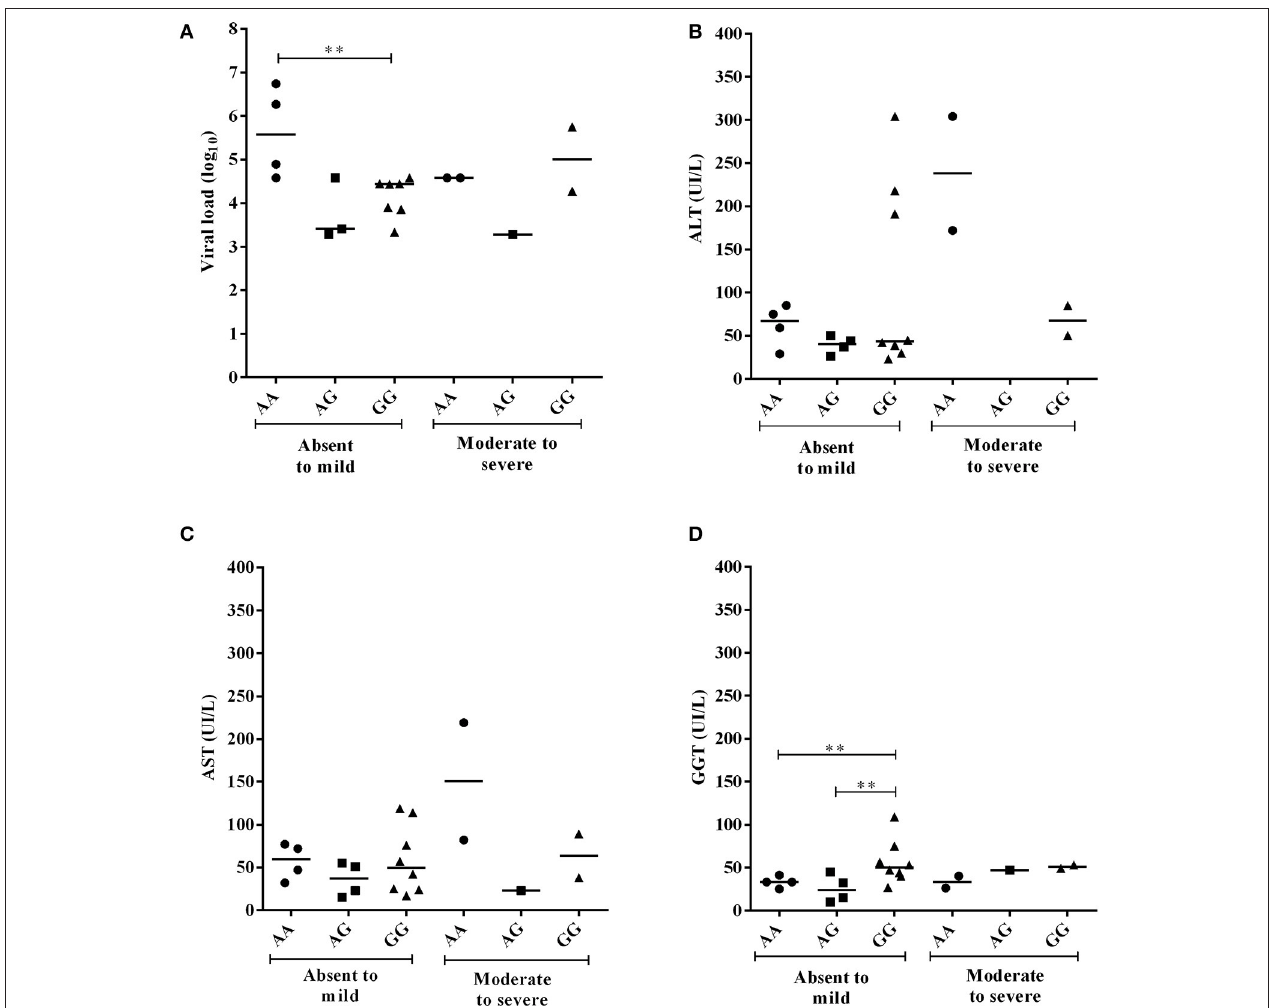
FIGURE 5 | Comparison of plasma viral loads (log 10 ) and liver enzyme levels in individuals with − 924A > G polymorphism genotypes in CHB-A patients according to the degree of inflammatory activity. Statistical significance was observed for the plasma viral loads (log 10 ) (A) and GGT levels (B) at the milder stages of tissue inflammation (**), but not to AST and ALT enzymes ( C,D